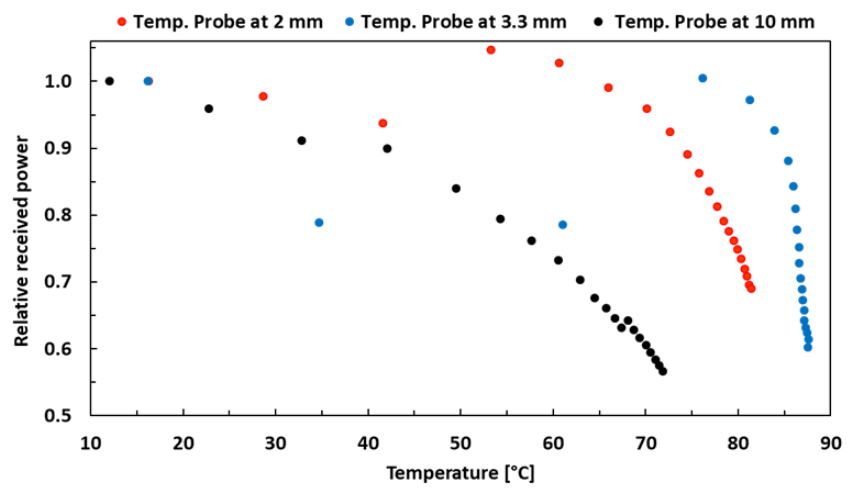
Figure 11. Received power vs. temperature for 50 W MWA in SP.